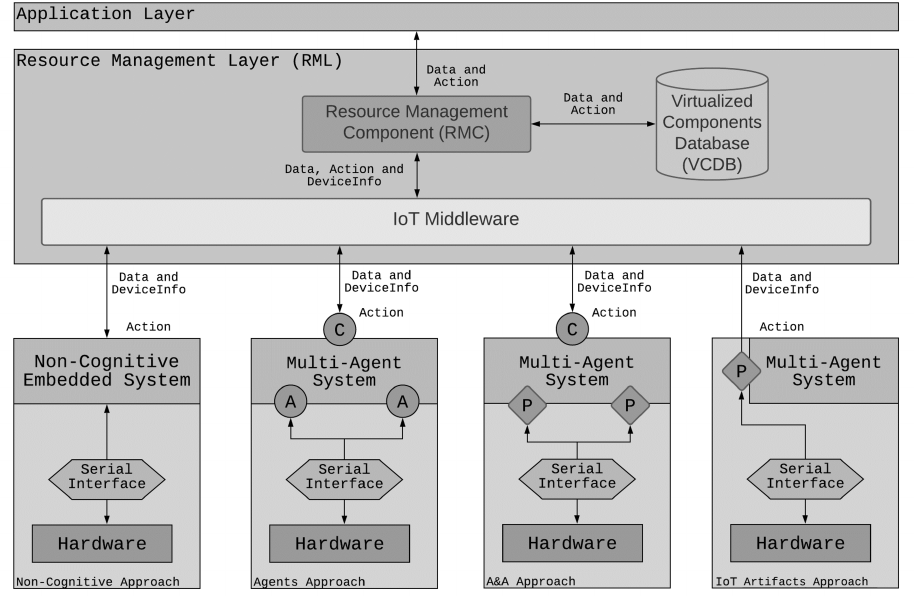
Figure 2. The extended Resource Management Architecture (RMA) and the three engineering ap- proaches in the Device layer: the Agents, Agents and Artifacts (A&A), and the IoT Artifacts